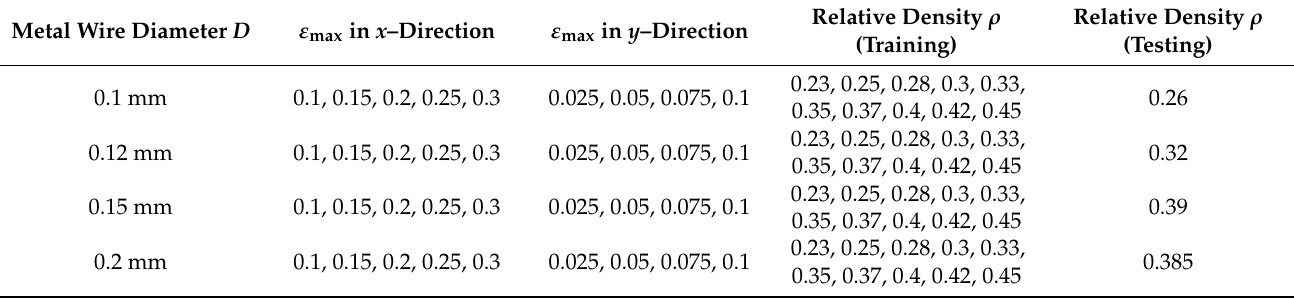
Table 1. Parameters of MR cube